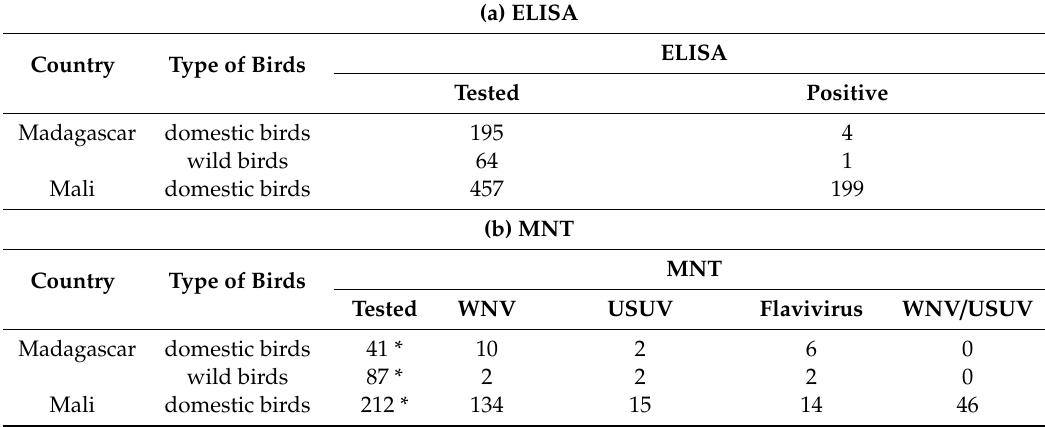
Table 2. ( a ) Number of birds sampled, tested by ELISA, and detected positive by ELISA in Madagascar (domesticandwildbirds)andinMali(domesticbirds); ( b )Numberofbirdstestedbymicroneutralization tests (MNT) and detected positive for West Nile virus (WNV), Usutu virus (USUV), undetermined flavivirus or for WNV / USUV in Madagascar (domestic and wild birds) and in Mali (domestic birds). (a) ELISA